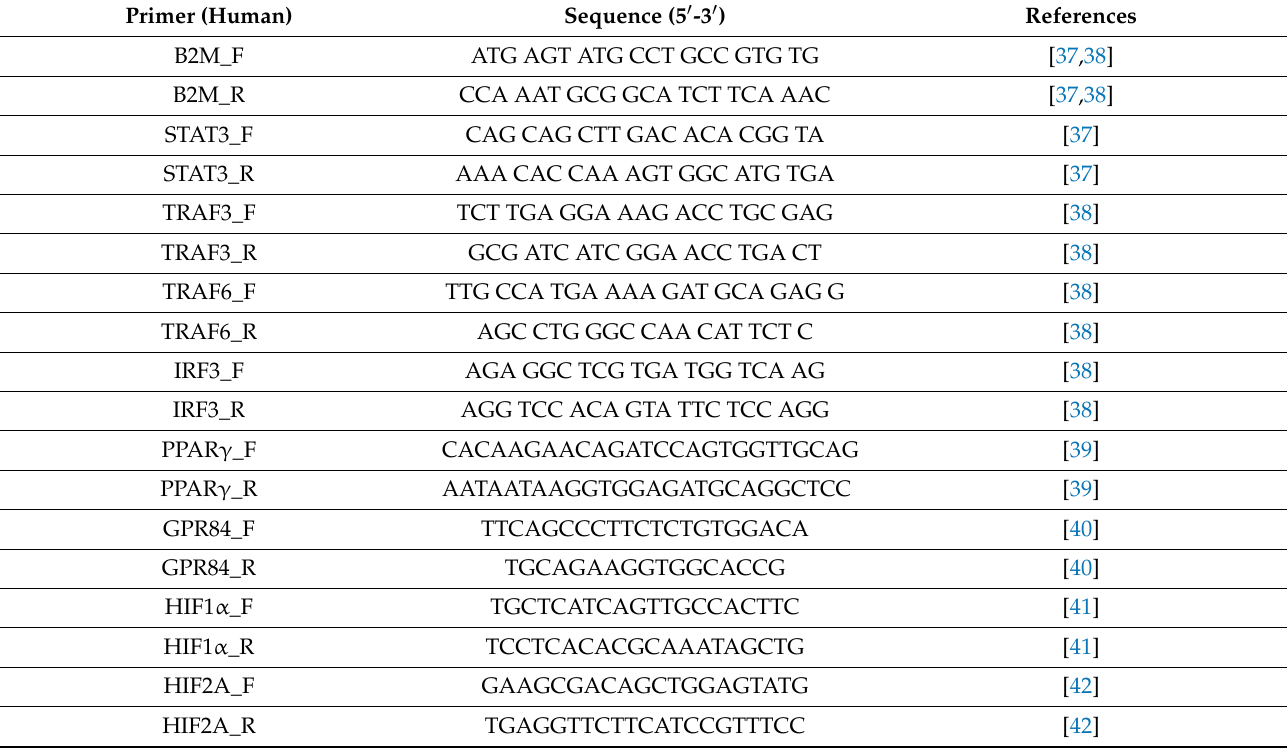
Table 1. Primer sequences used for qPCR to determine gene expression levels. Primer (Human) Sequence (5 (cid:48) -3 (cid:48)